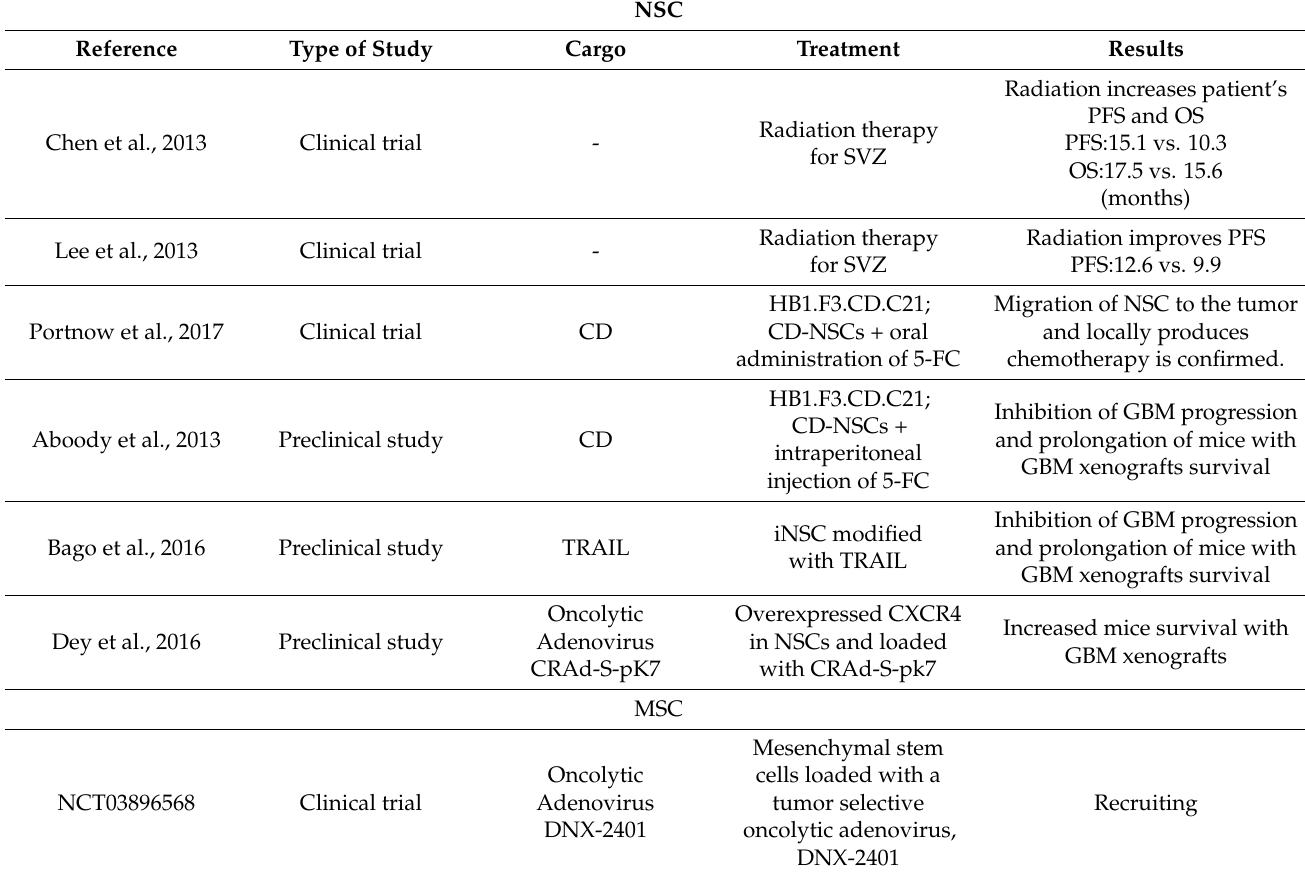
Table 1. List of the current preclinical and clinical trials used in the application of MSC and NSC against